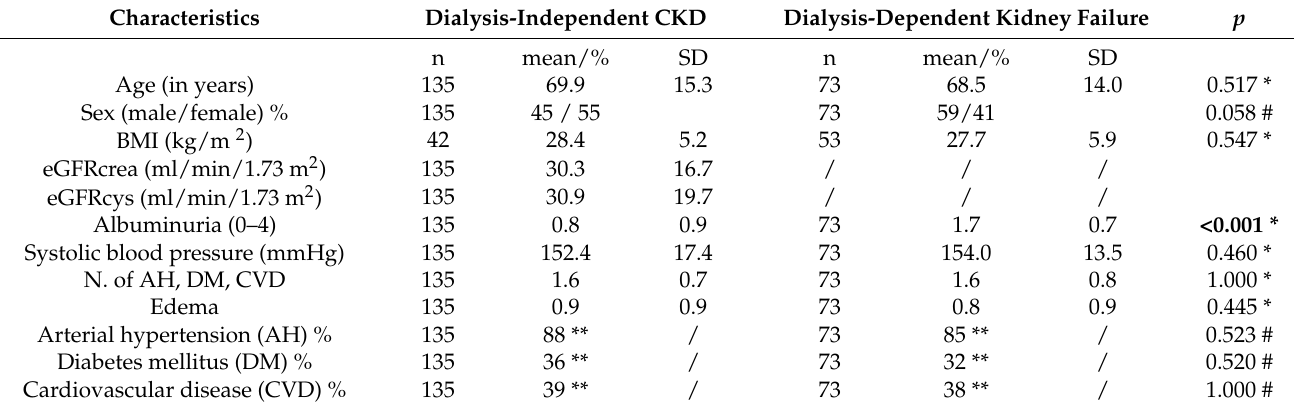
Table 1. Demographics and clinical phenotypes in the examined patient